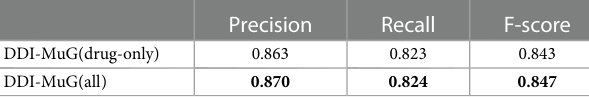
TABLE 5 The comparison of with or without verbs information. The highest value is labelled in bold.